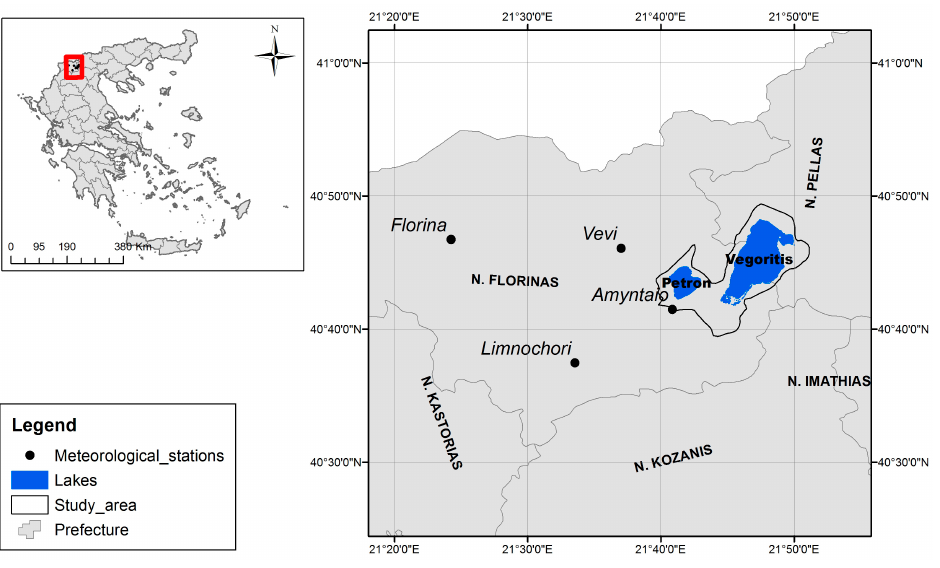
Figure 1. Location of the studied area in north Greece.